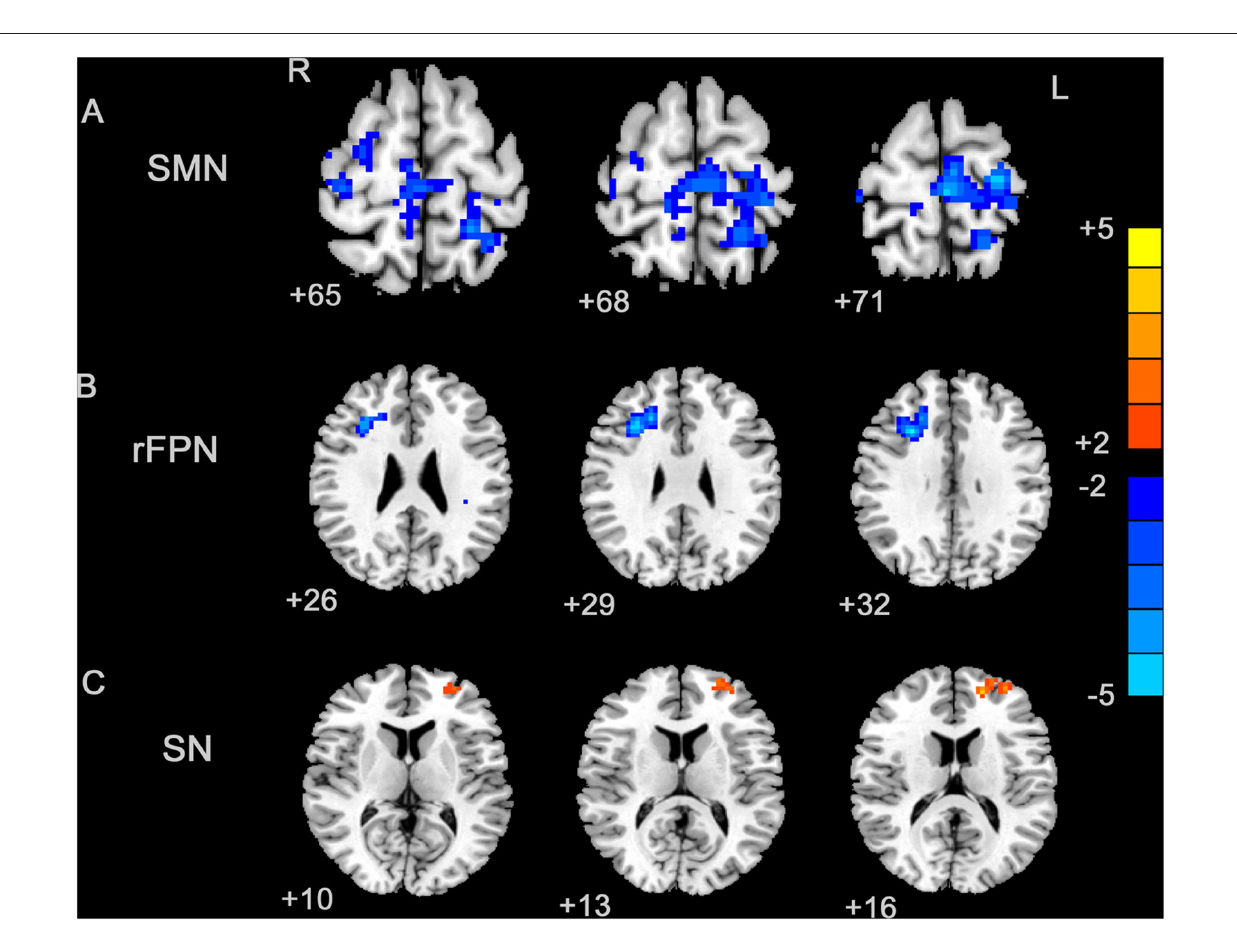
Frontiers in Human Neuroscience | www.frontiersin.org